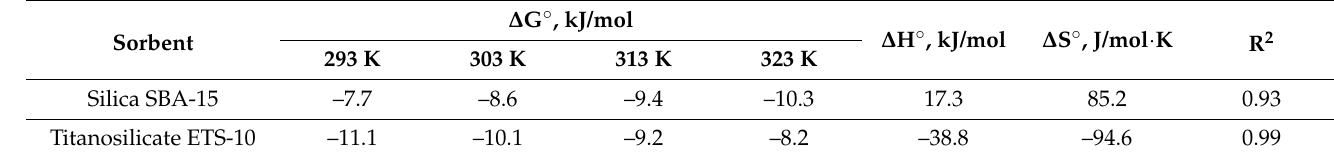
Table 3. Thermodynamic parameters of indium sorption on silica SBA-15 and titanosilicate ETS-10.